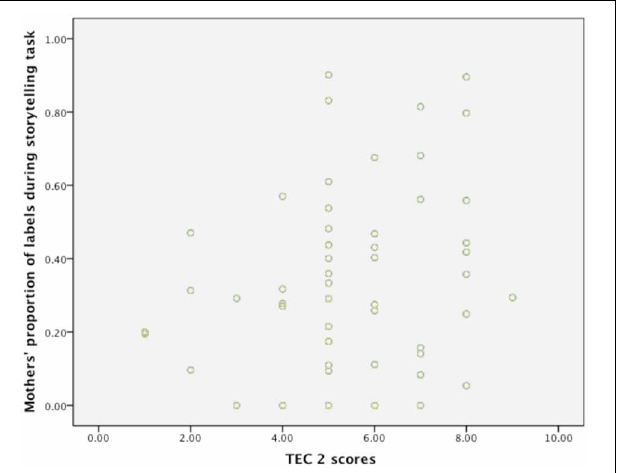
FIGURE 1 | Proportion of labels used by mothers during the storytelling task and TEC 2